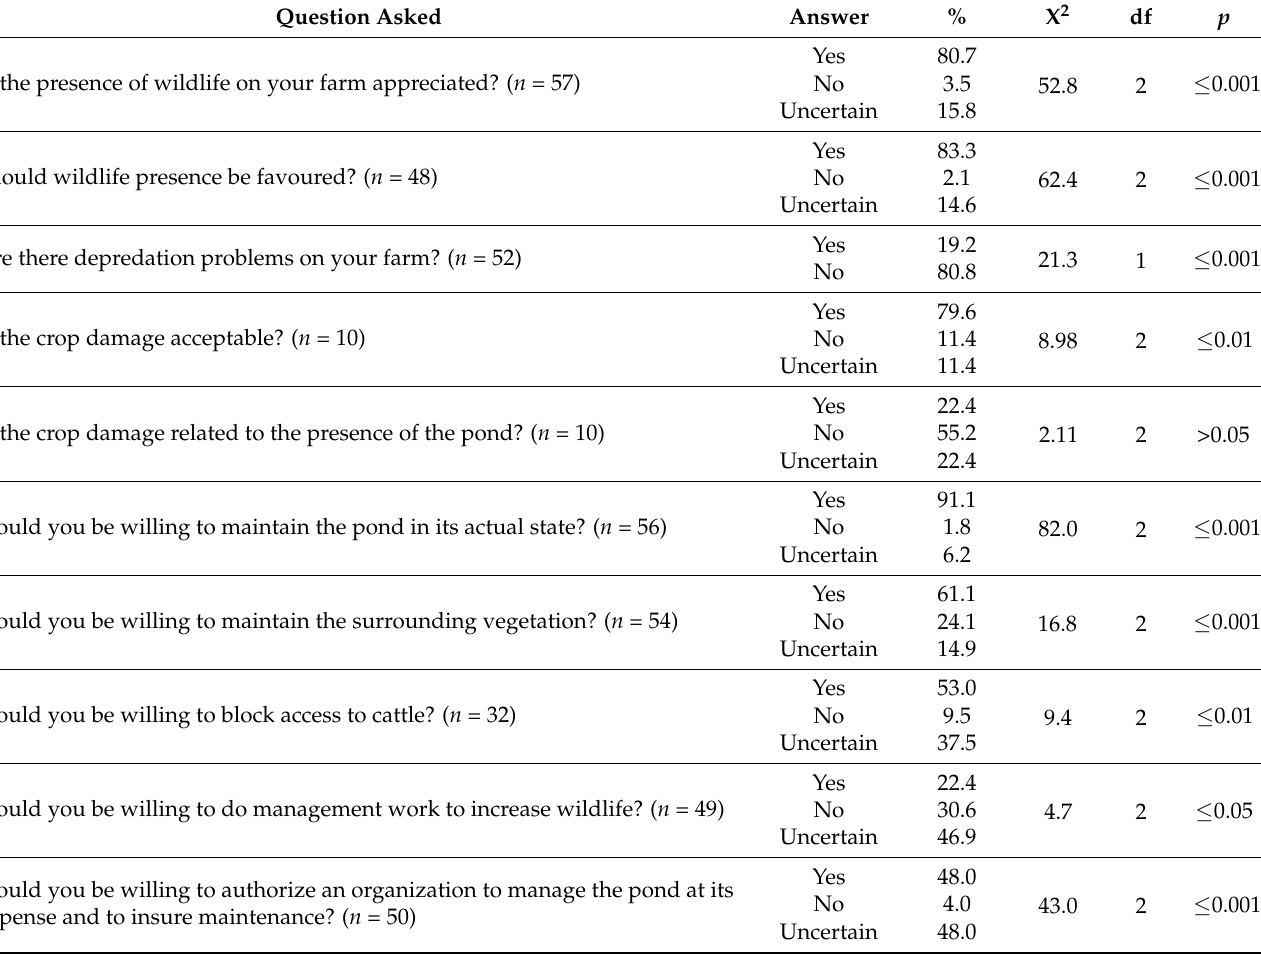
Table 5. Results of the survey of landowners’ perception of the presence of farm ponds on their lands and their willingness to maintain them for a greater wildlife use, Boyer River watershed, St. Lawrence Valley lowlands, Southern Quebec (Canada). Question